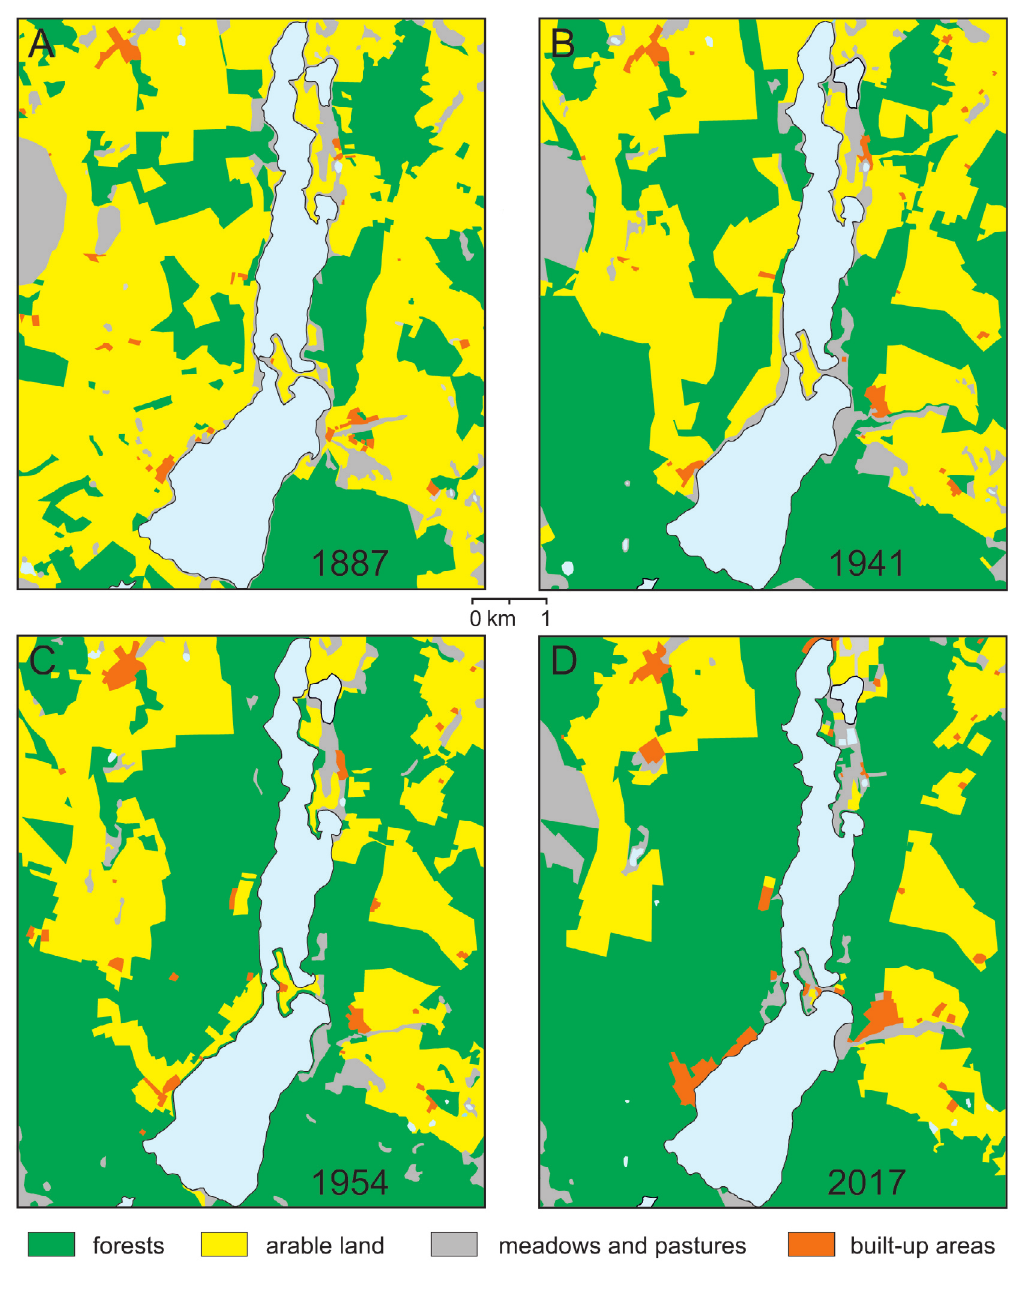
Fig. 5. The structure of land use in the studied area in the years